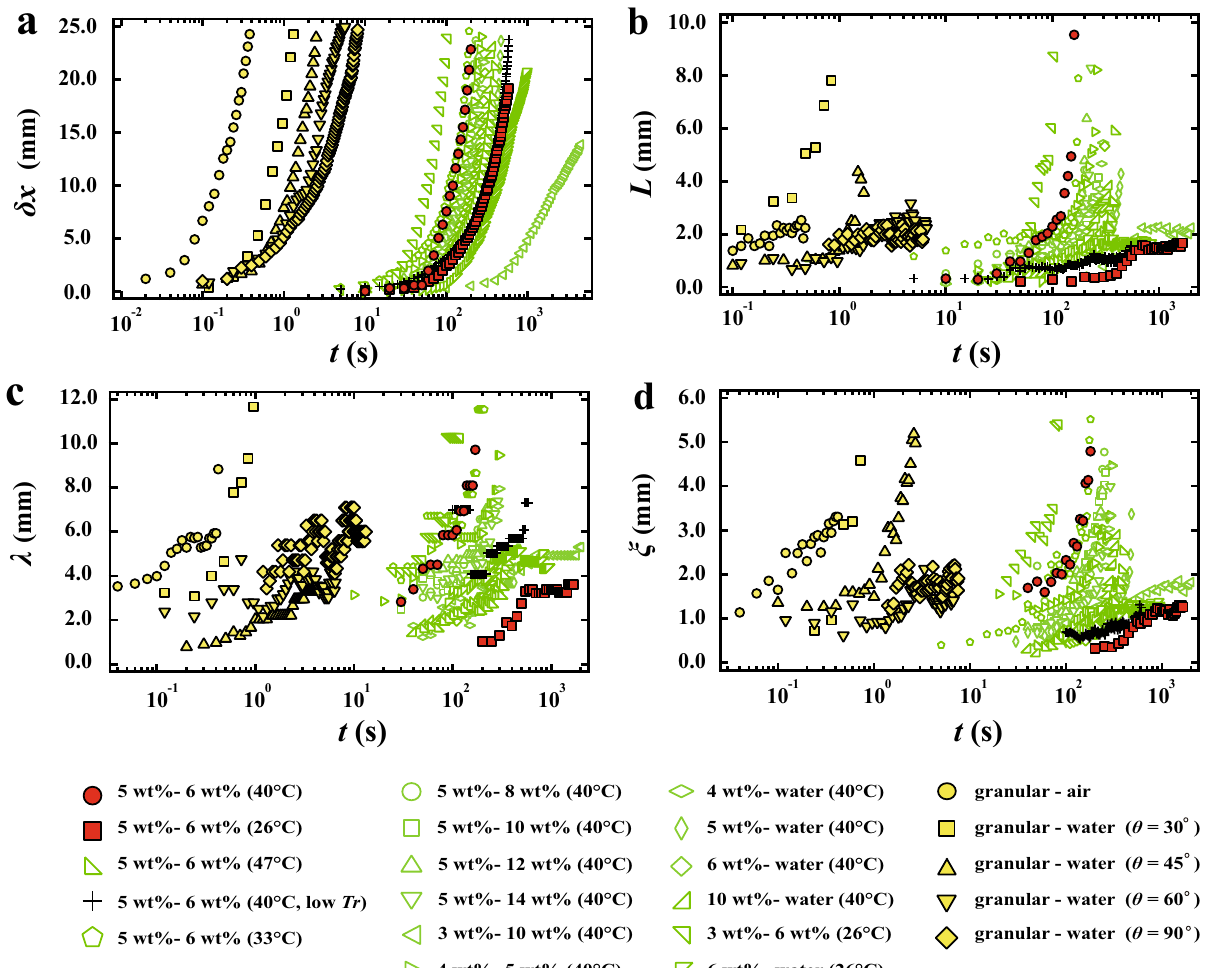
Figure 6. Time evolutions of the gravitational instability for gels and granular systems. ( a ) the front position δ x , ( b ) the thickness of flowable region L , ( c ) the mean distance between the fingers (cid:31) , ( d ) the mean width of fingers ξ